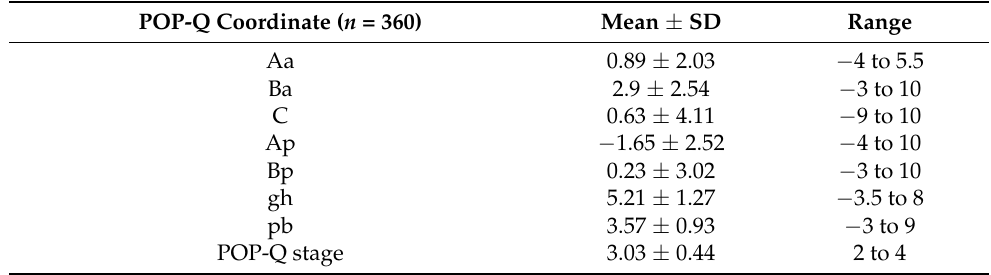
Table 2. International Continence Society Pelvic Organ Prolapse Quantification (POP-Q) exam